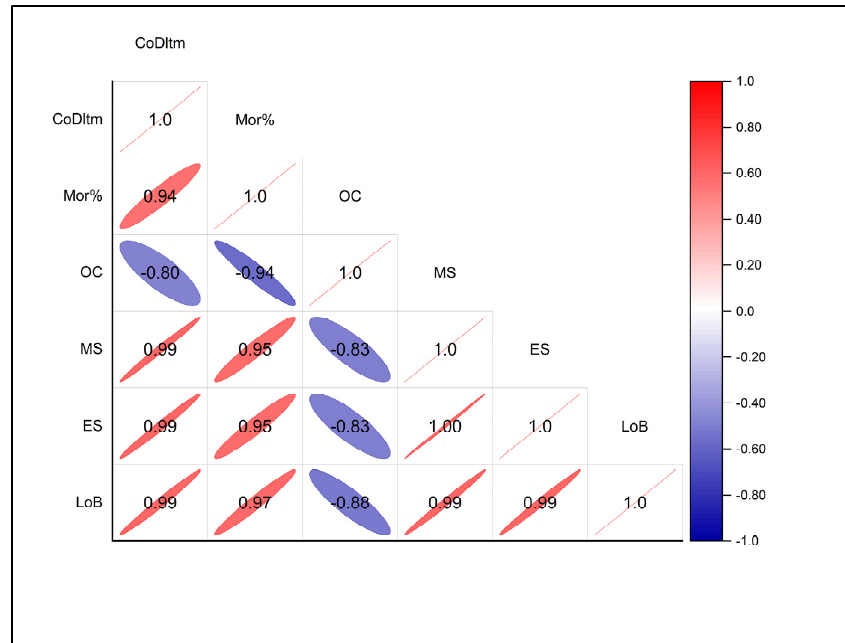
Figure 5. Correlation plot between deltamethrin concentration (CoDltm), mortality percentage (MOR%), and behavioral biomarkers; i.e., erratic swimming (ES), mucous secretion (MS), movement (M), erratic swimming (ES), loss of balance (LoB), and oxygen consumption (OC) for O. mossambicus .